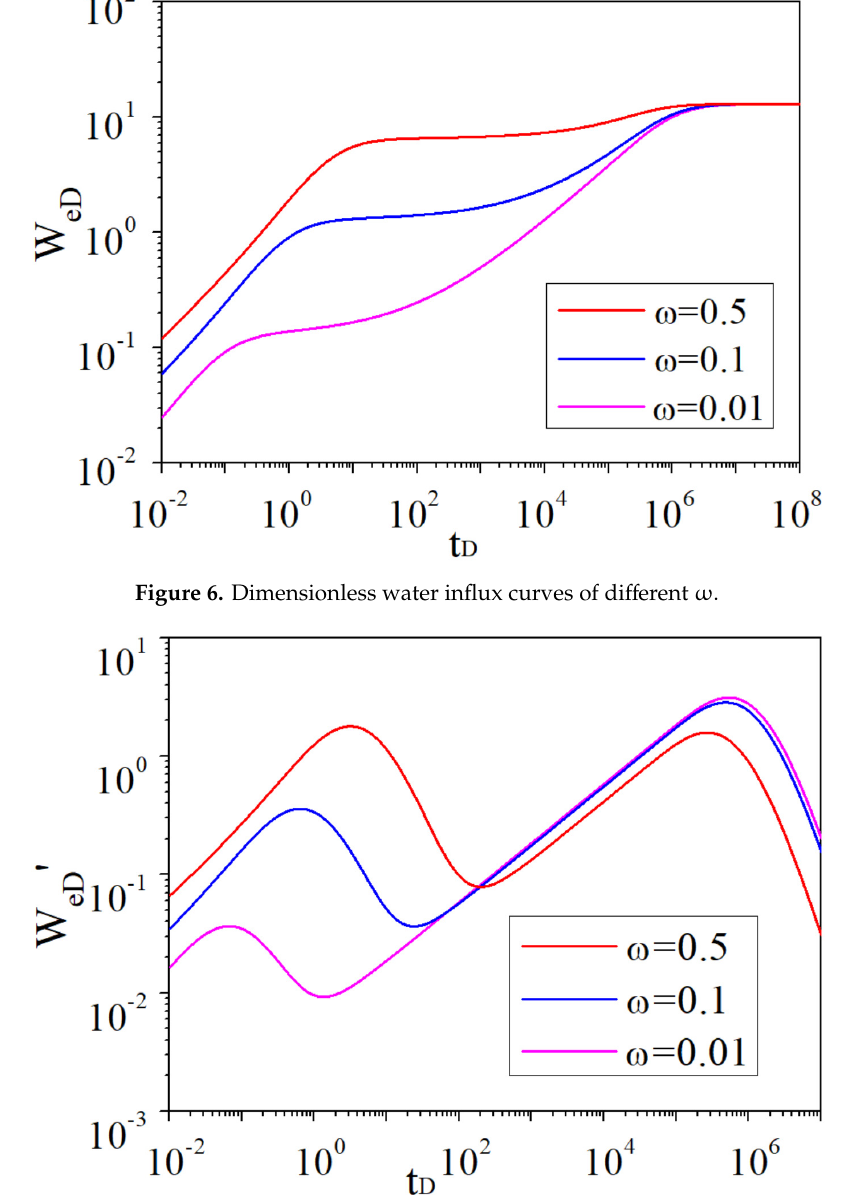
Figure 7. Dimensionless water influx derivative curves of different ω .